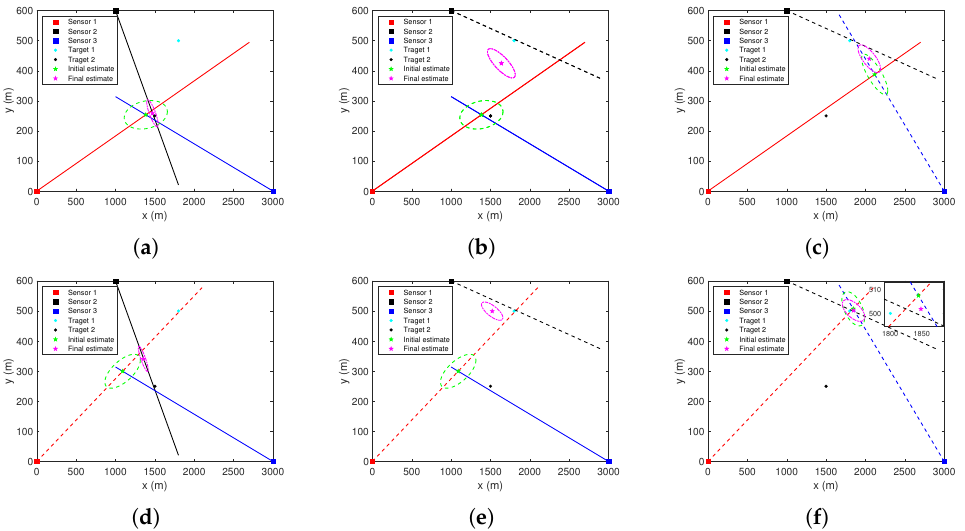
Figure 8. The initial estimate and the estimate after l iterations obtained using different stacked measurement vectors. ( a ) z 111